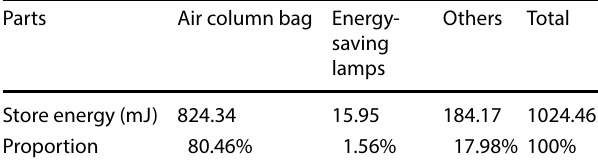
Table 5 Initial inflation pressure: 50